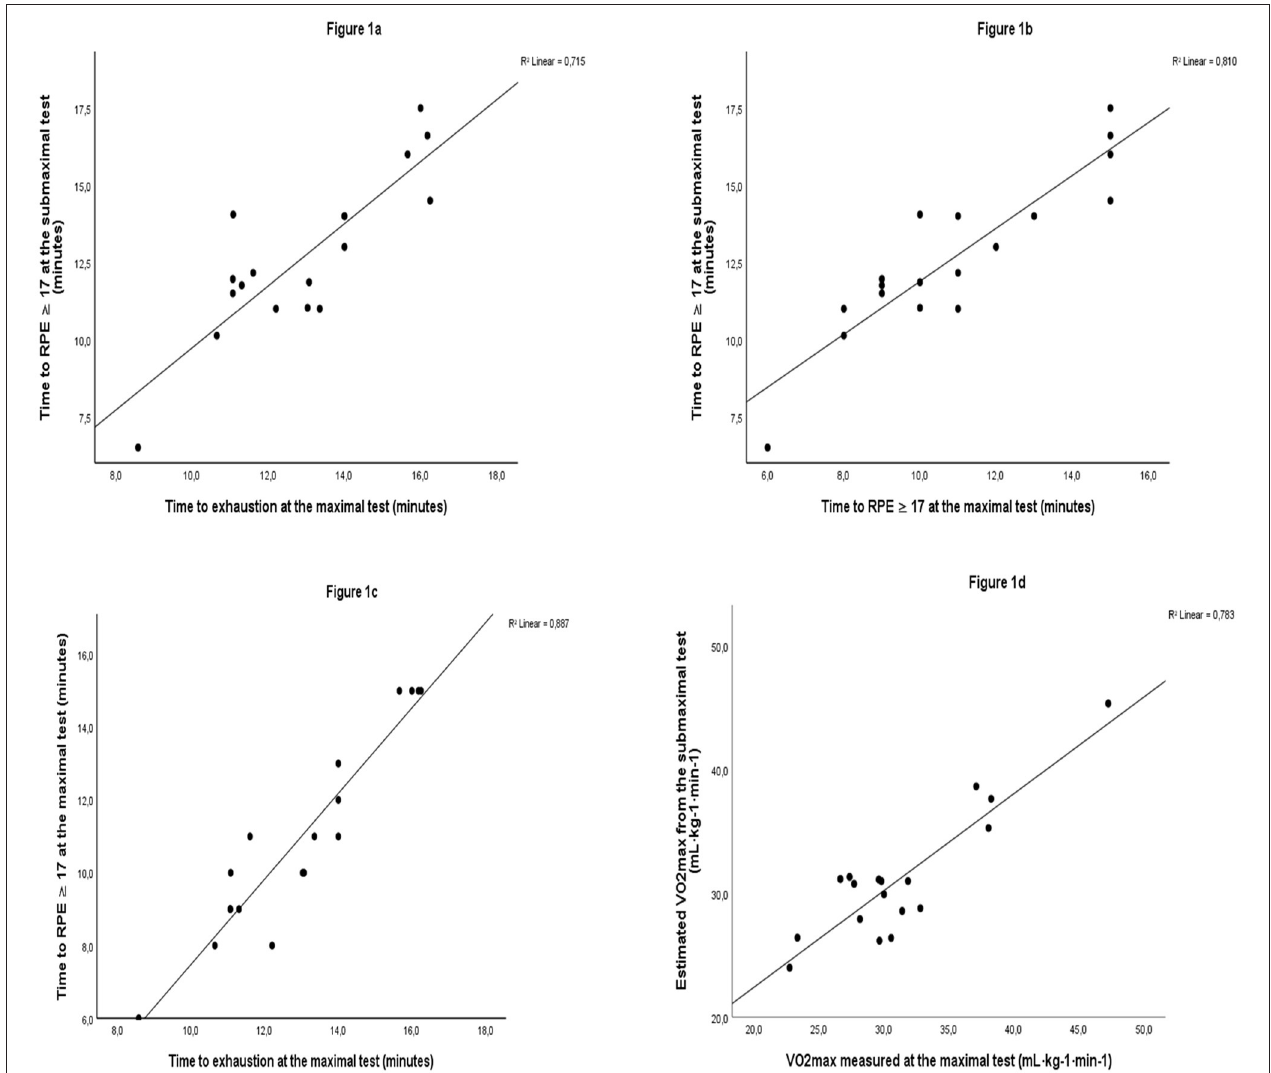
FIGURE 1 | The correlation between time to RPE ≥ 17 at the submaximal test and time to exhaustion at the maximal test (a) , time to RPE ≥ 17 at the submaximal test and time to RPE ≥ 17 at the maximal test (b) , time to RPE ≥ 17 at the maximal test and time to exhaustion at the maximal test (c) , and estimated VO 2max and measured VO 2max (d) in individuals at high risk of getting or with established chronic diseases.